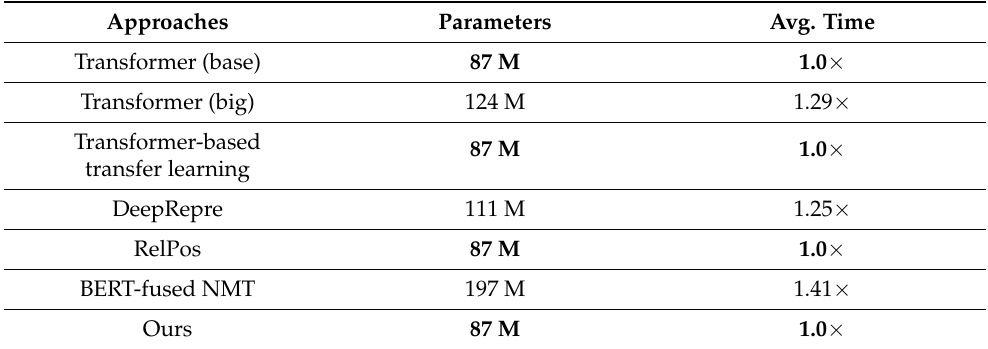
Table 3. The parameters and average inference speed between the baselines and our approach.